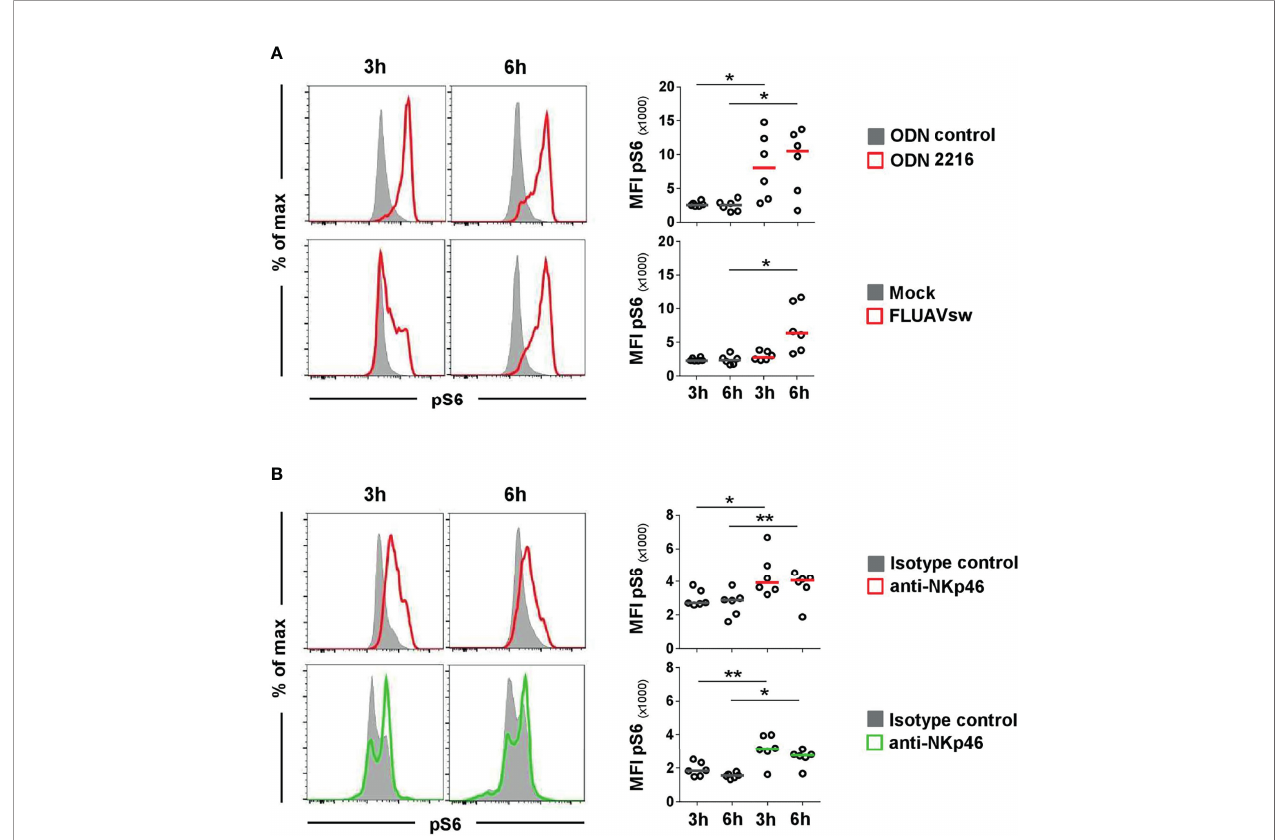
FIGURE 4 | Flow cytometric analyses of phosphorylated ribosomal protein S6 (pS6) after stimulation of pDCs and NK cells. Induction of pS6 in pDC and NK-cell populations was assessed by analyzing the median fl uorescence intensity after in vitro stimulation of PBMC. Phosphorylated S6 was detected intracellularly after fi xation and permeabilization of cells by multicolor FCM. (A) For detection of pS6 in pDCs, PBMC were incubated with the TLR9 agonist ODN 2216 (red, upper row) or with a FLUAVsw H1N2 isolate (red, bottom row) for 3 and 6 h. Cells incubated with non-stimulatory oligonucleotides (ODN control, gray, upper row) or mock (gray, bottom row) served as corresponding controls. (B) Activation by NKp46 triggering of pDCs (red, upper row) and NK cells (green, bottom row) was assessed after a 3- and 6-h incubation of PBMC with plate-bound NKp46 mAbs. Plates coated with isotype-matched irrelevant antibodies served as controls (gray). PBMC for NK-cell analyses were additionally pre-activated with rpIL-2 and rpIL-15 for 24h. (A, B) Histograms show results of pS6 induction for one representative animal. Plasmacytoid DCs and NK cells were identi fi ed by phenotyping as outlined in Figure 2A . MFIs of pS6 within pDCs and NK cells are shown for analyses of six animals in the graphs on the right. Median values are represented by colored bars. Signi fi cant differences between stimulated and non-stimulated cells were calculated within the same incubation period and are indicated (* p ≤ 0.05 , ** p ≤ 0.01